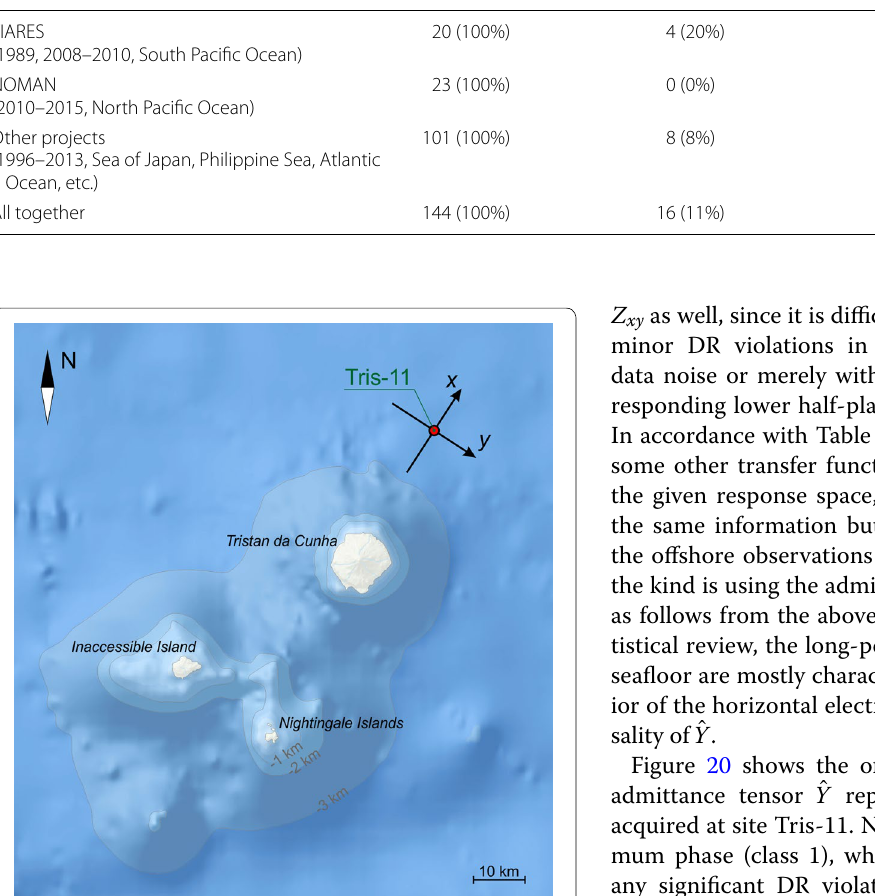
Fig. 18 Location of the seafloor MT site Tris-11 in the South Atlantic. The employed coordinate axes are rotated 33° clockwise with respect to the geographical